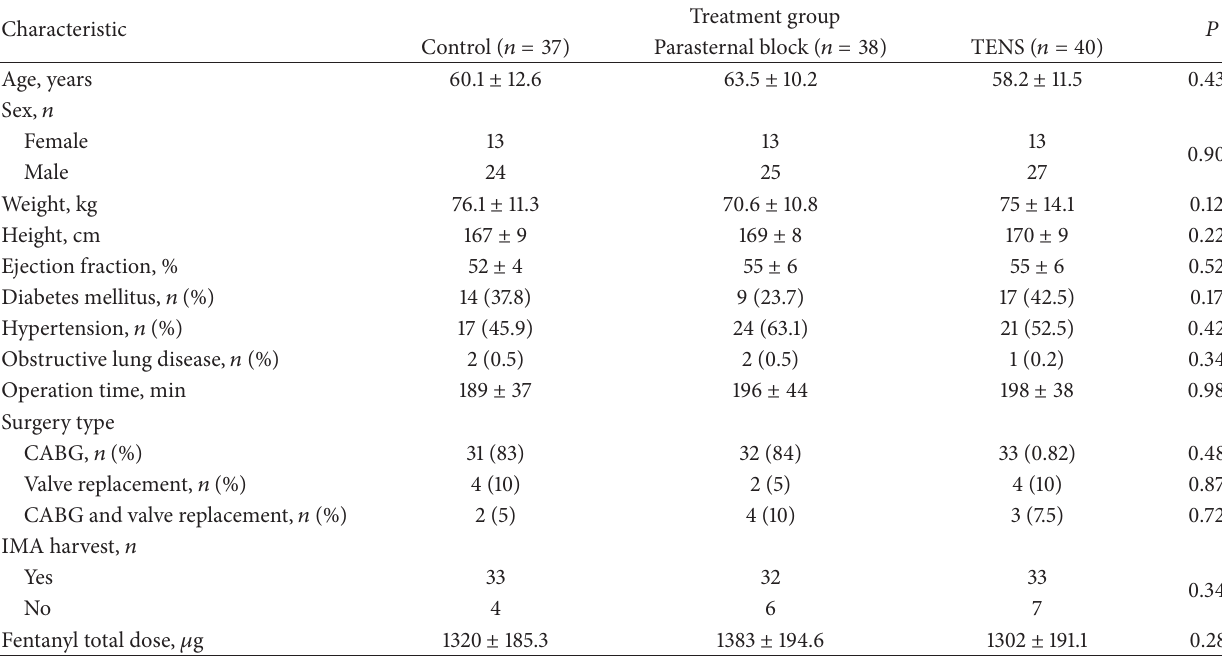
Table 1: Demographic and perioperative